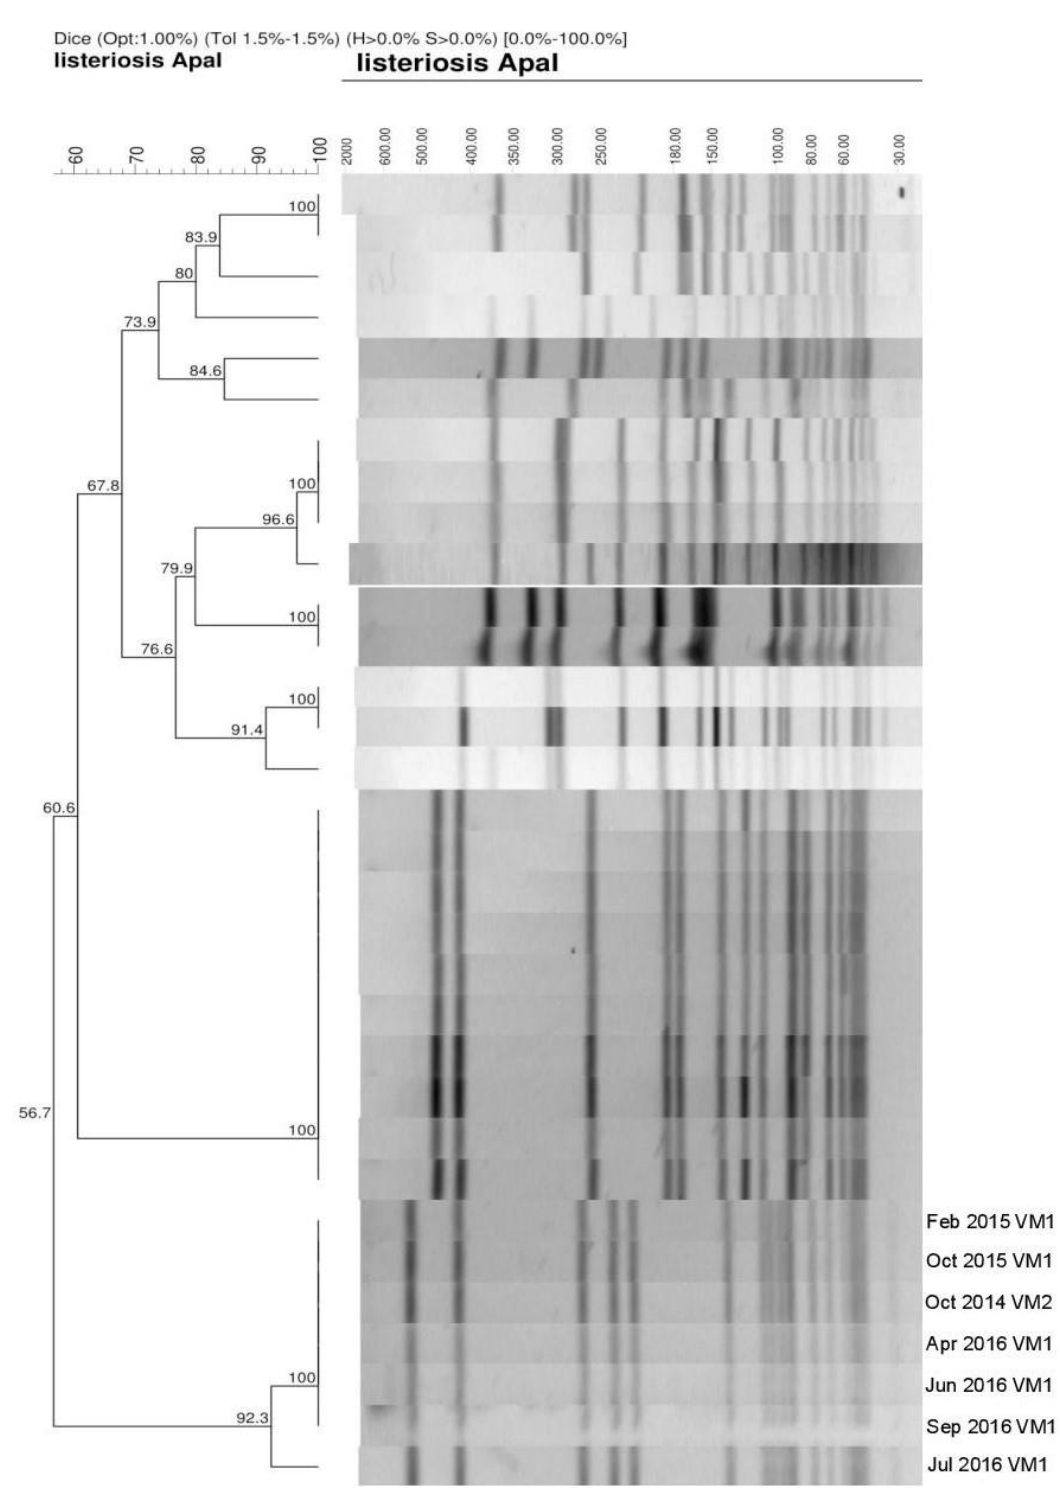
Figure 1. Pulsed-Field Gel Electrophoresis (PFGE) patterns restricted with Apa I enzyme. Marked lines 1–3 present isolates patterns from the first survey (2014–2015), lines 4–7 are isolates from presented study (2016/2017). VM1, VM2 = vending machines from the same producer.